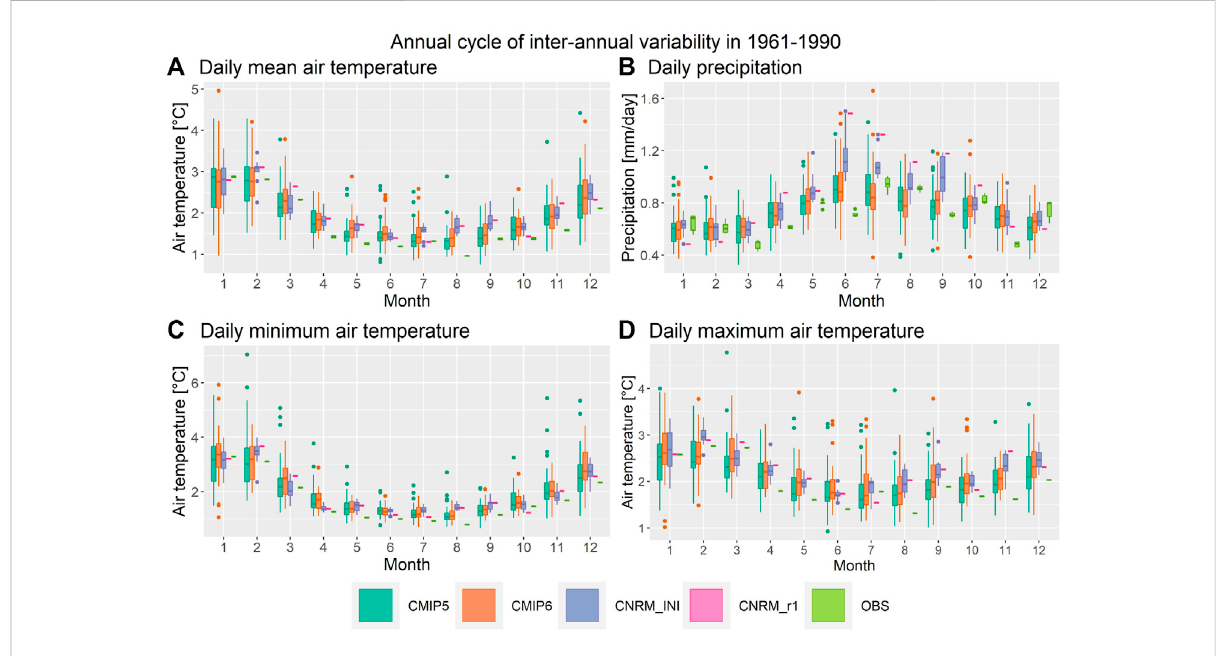
FIGURE 3 Same as Figure 2, but for standard deviation of monthly mean